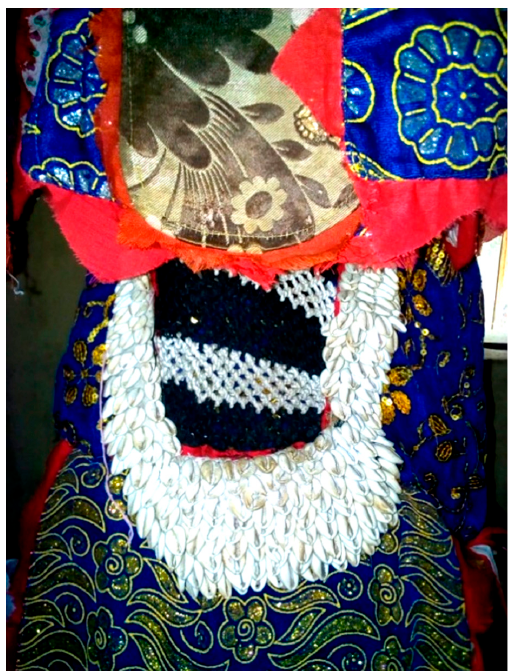
Figure 9. Close-up of Egúngún Mowuru’s Face Veil. Source: Photograph by author.